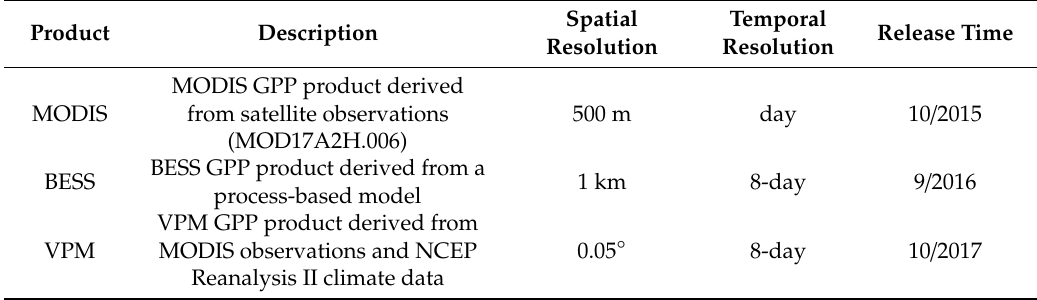
Table 1. Datasets of the satellite-based gross primary production (GPP) used in this study. Product Description